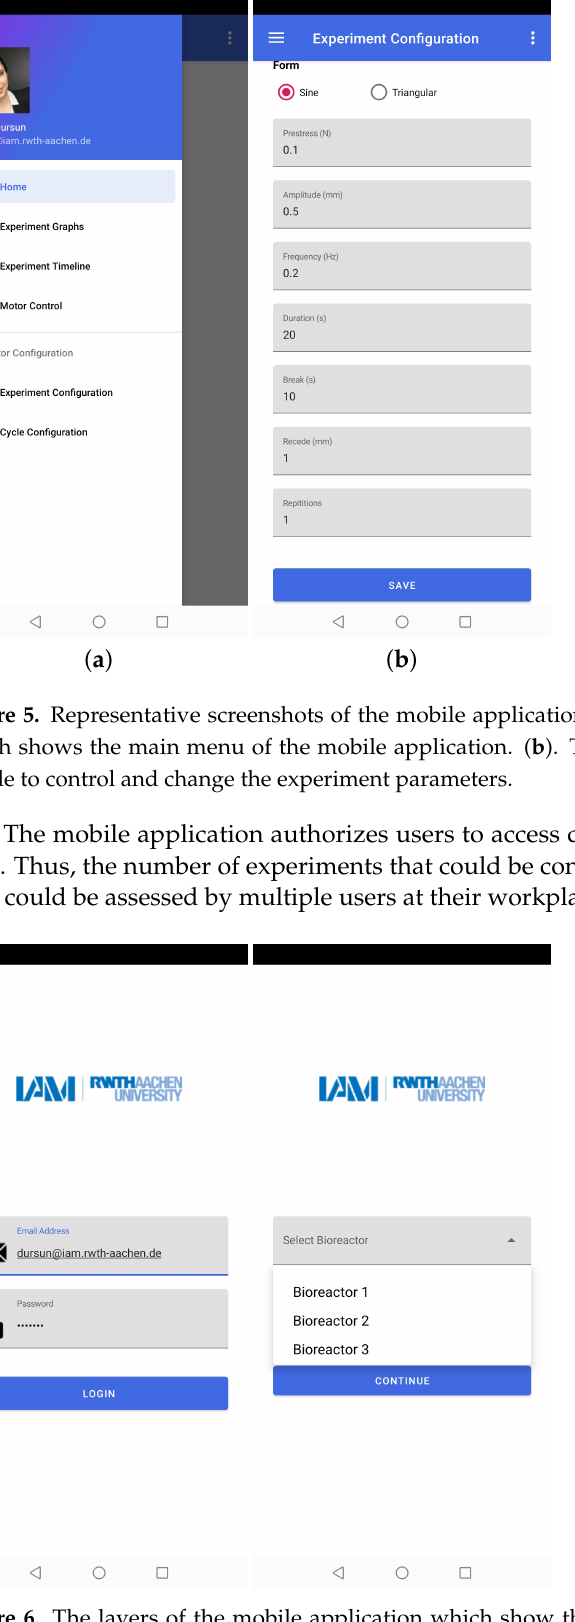
Figure 6. The layers of the mobile application which show the access of different users by mail addresses and choice of bioreactor with their corresponding